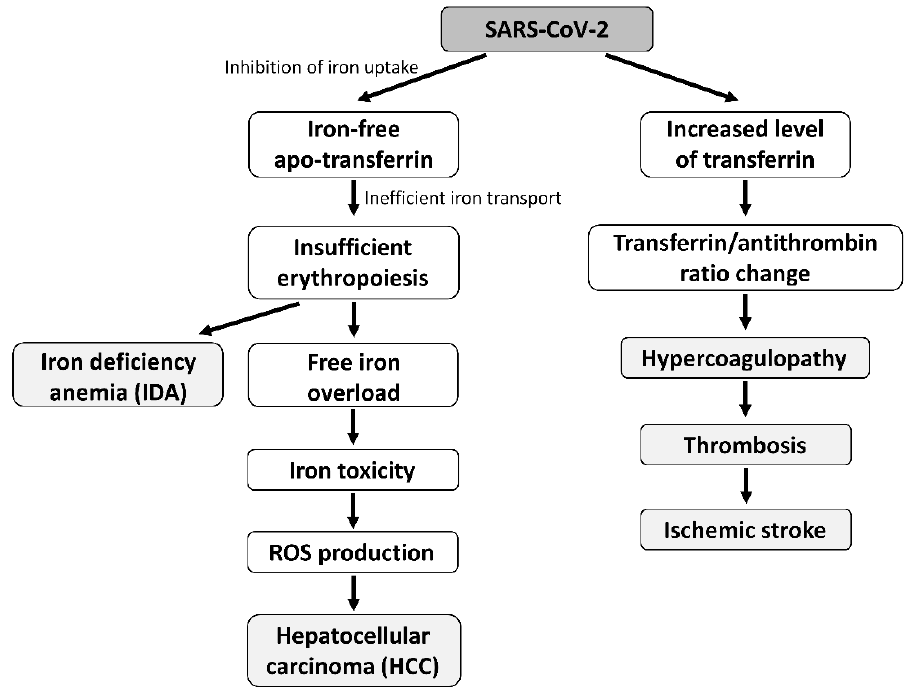
Figure 7. A schematic flow chart model of the possible relationship between the effect of SARS-CoV-2 on transferrin and COVID-19-related severe diseases. The left flow chart represents how SARS-CoV-2 may affect transferrin by inhibiting Fe 3+ uptake, leading to IDA and HCC. The right flow chart of the model summarizes the literature data of how the increased transferrin level changes the transferrin/antithrombin ratio [29], probably causing hypercoagulopathy, thrombosis, and ischemic stroke.